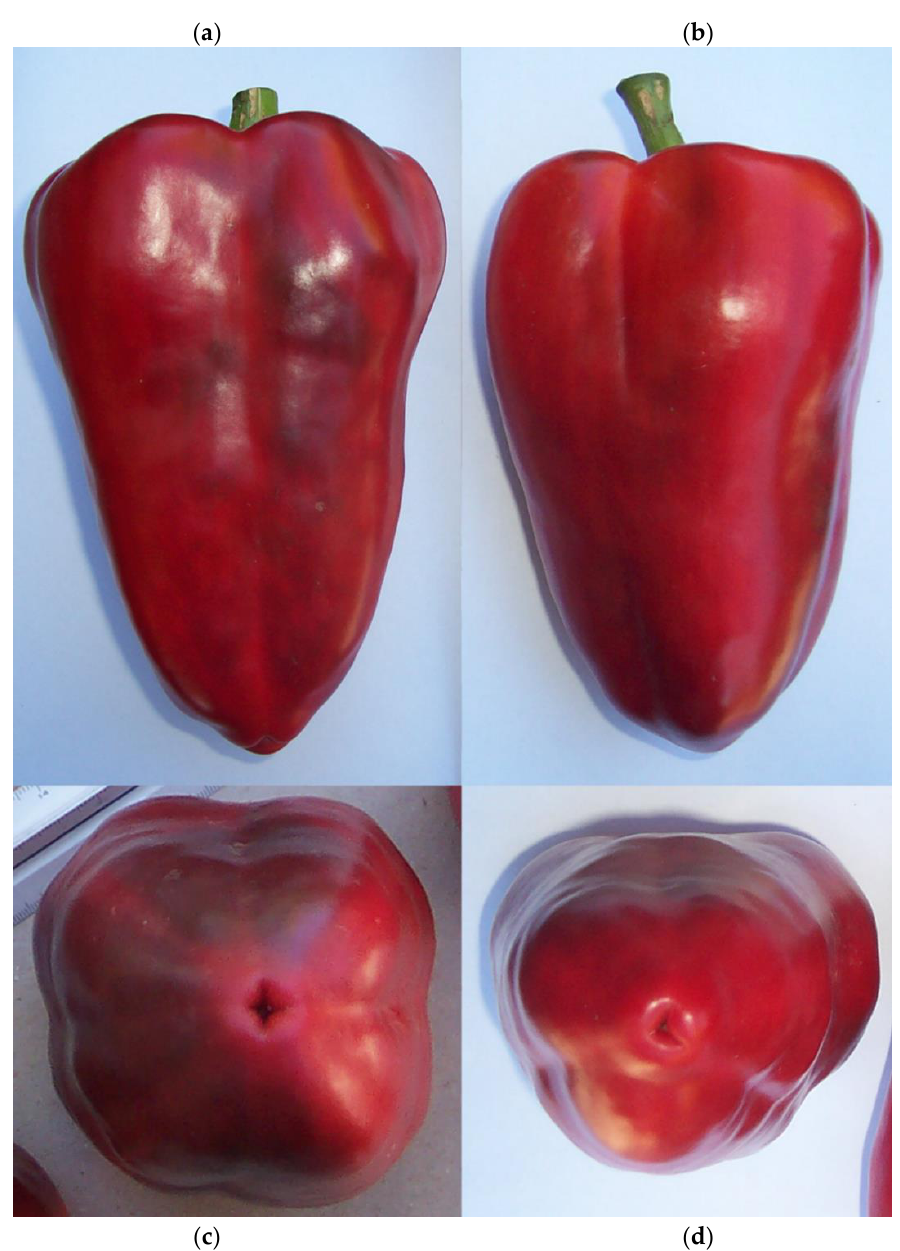
Figure 1. Side view of tetralocular pepper ( a ) and trilocular pepper ( b ), and bottom view of tetraloc- ular pepper ( c ) and trilocular pepper ( d ). Table 2. Morphological characteristics of industrial fresh pepper. Table 2. Morphological characteristics of industrial fresh